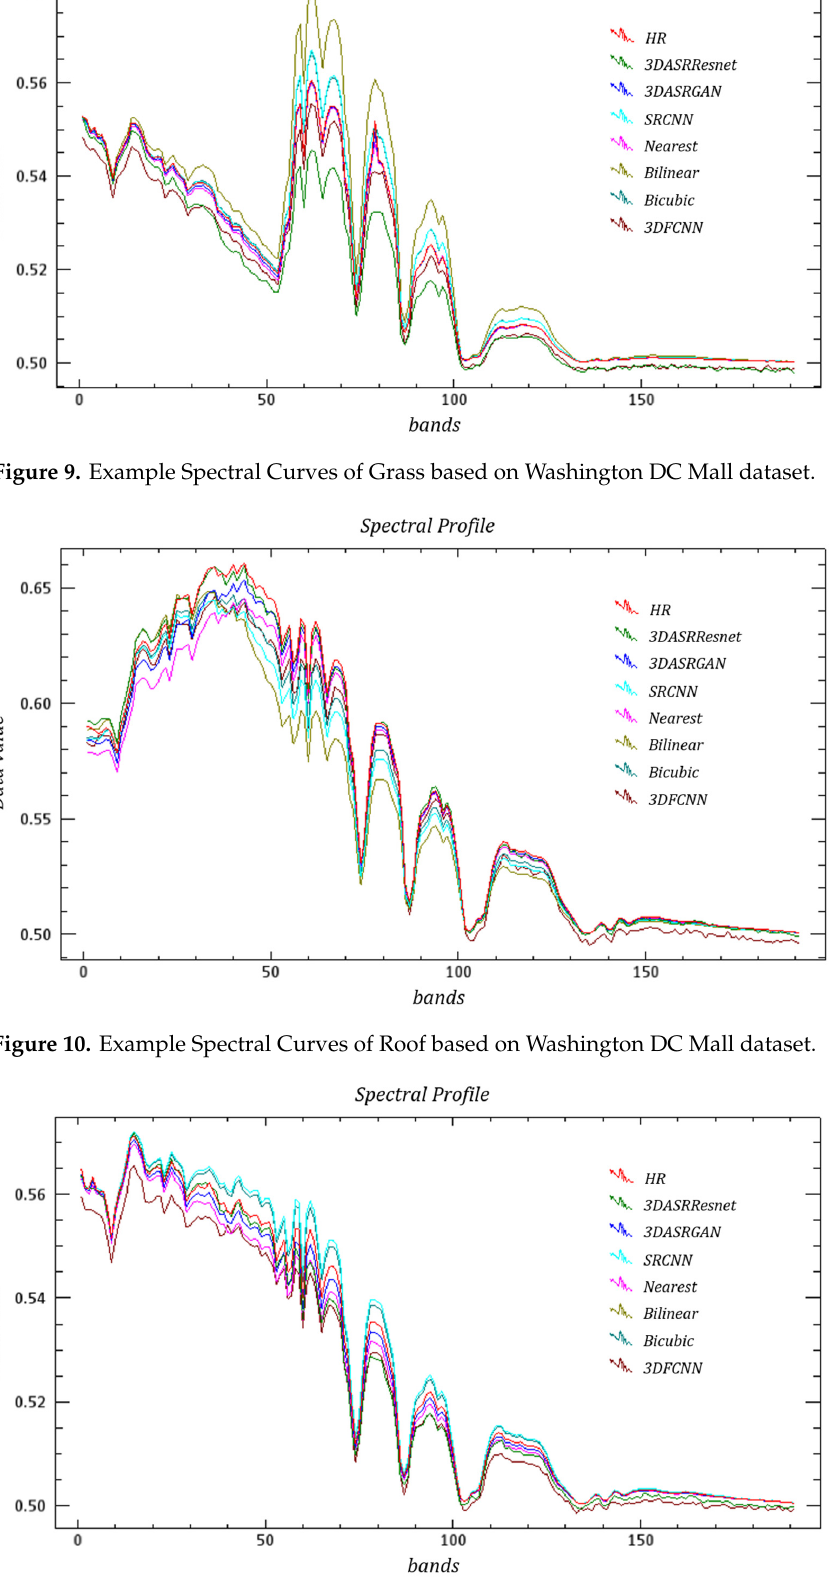
Figure 11. Example Spectral Curves of Roads based on the Washington DC Mall dataset.